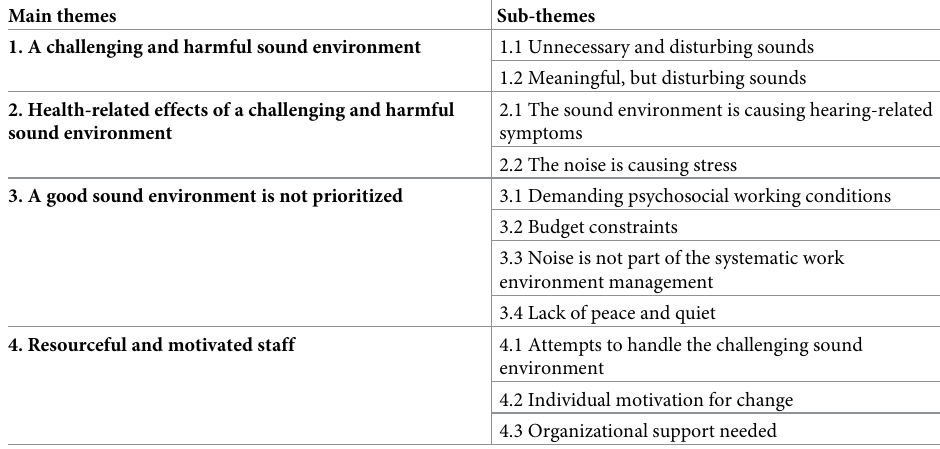
Table 3. Main themes and sub-themes.